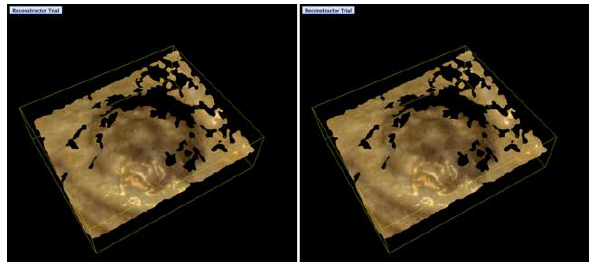
Figure 11. Creating mesh into Reconstructor